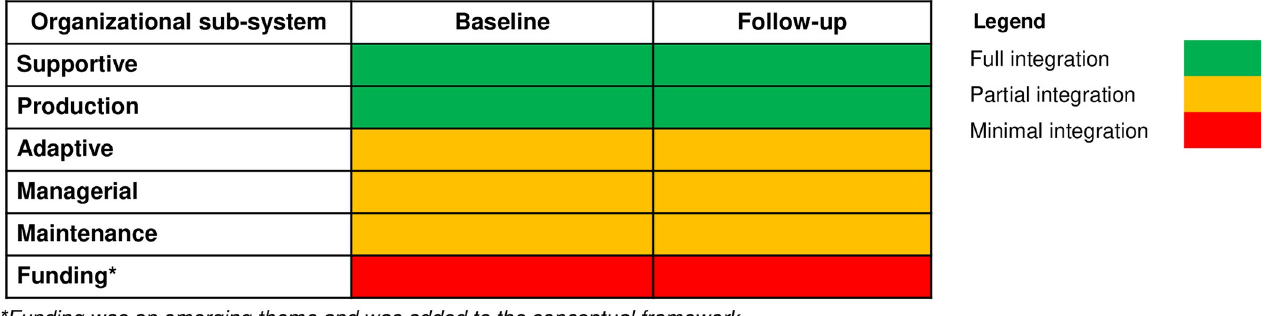
Fig 3. Extent of aPS integration across organizational subsystems.